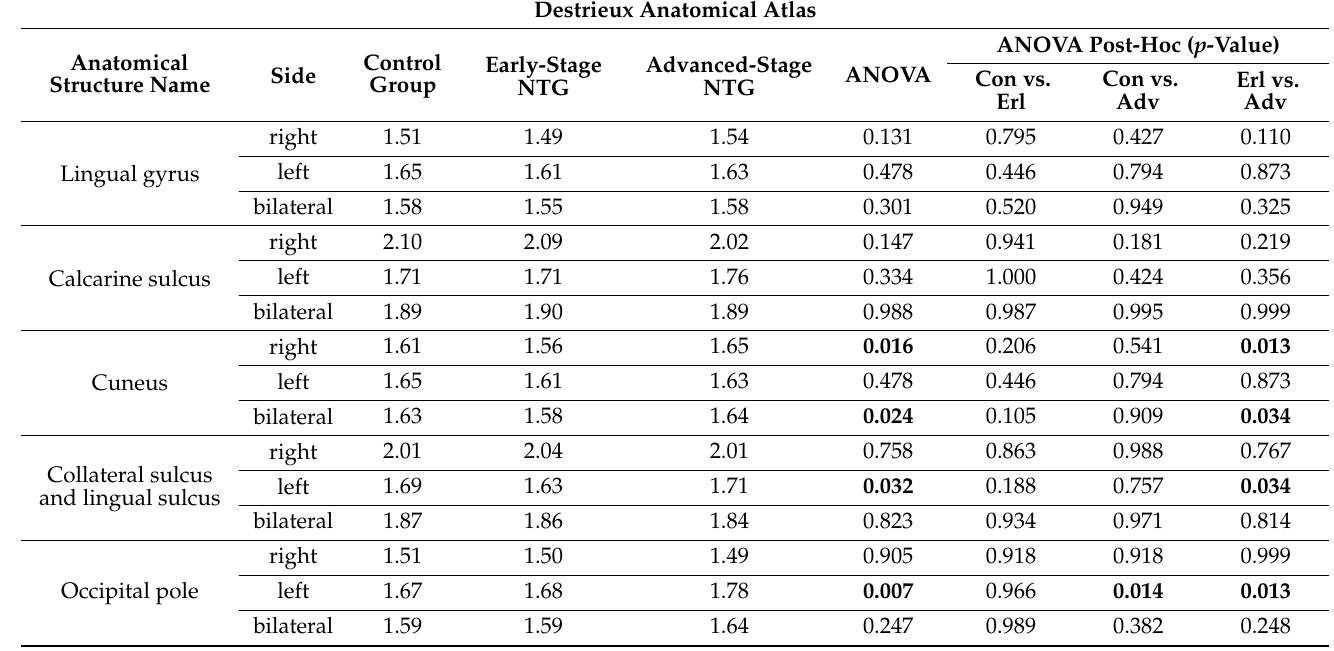
Table 2. Mean cortical thickness results in selected visual regions based on Destrieux cortical parcel- lation atlas in control and NTG groups. Statistically significant results are marked bold.